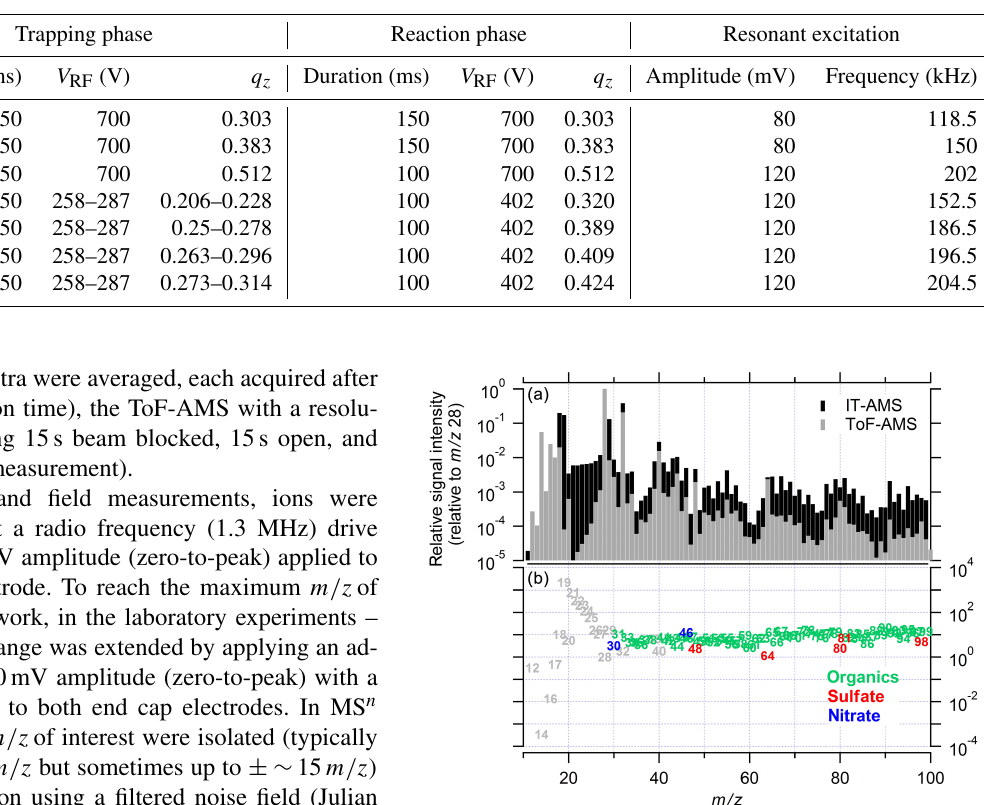
Table 2. IT-AMS operating parameters in the MS n studies. V RF is the amplitude (zero-to-peak) of the radio frequency drive voltage (1.3MHz) applied to the ring electrode; q z is the stability parameter resulting from the Mathieu equation (March, 1997). The resonance frequency was experimentally determined.